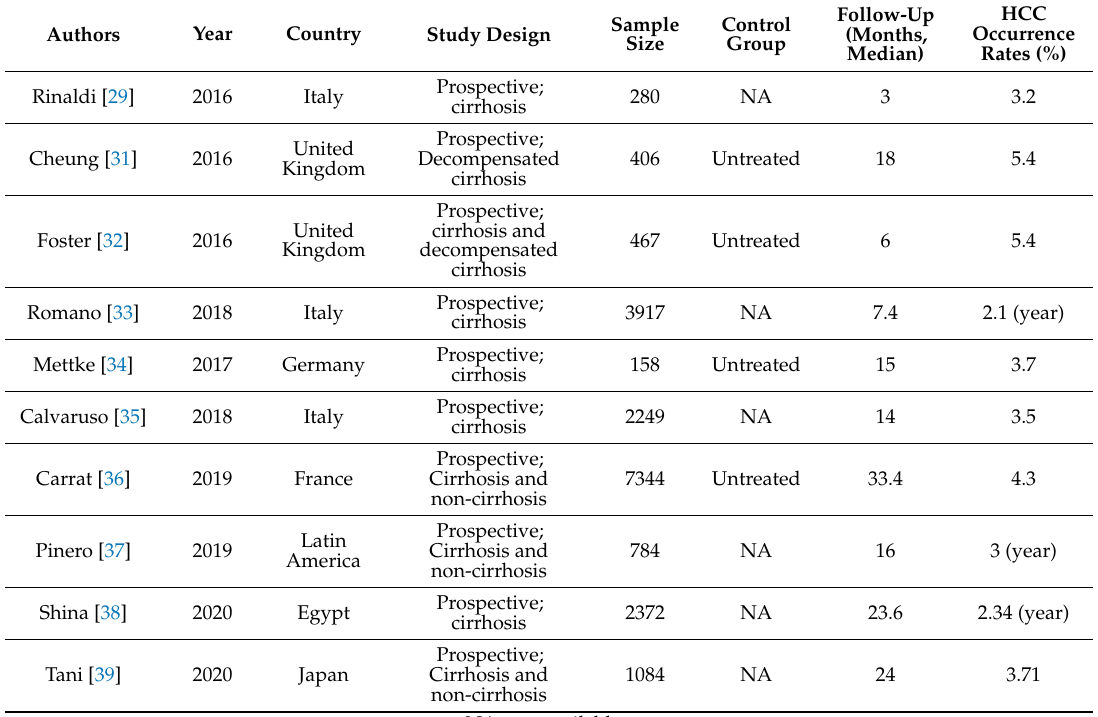
Table 1. Prospective study of hepatocellular carcinoma (HCC) occurrence after rapid virologic response (SVR) by direct-acting antivirals